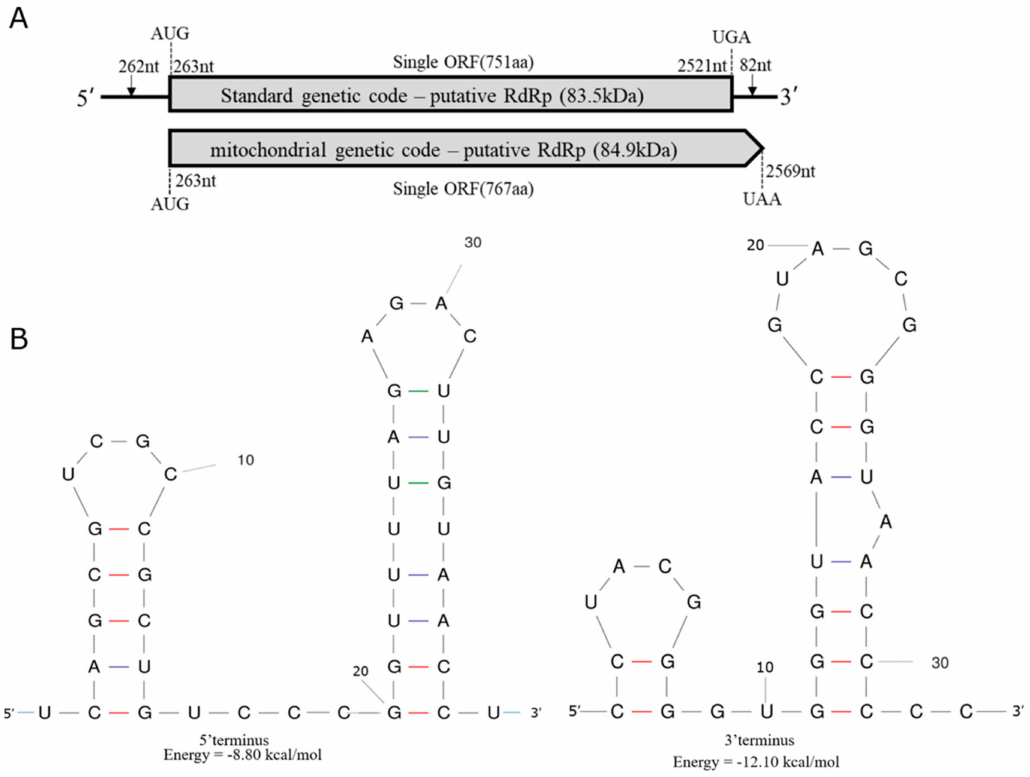
Figure 1. The genome organization of Phoma matteucciicola ourmia-like virus 1 (PmOLV1). ( A ) Schematic representation of PmOLV1 RNA genome. The open reading frame (ORF) and the untranslated regions (UTRs) are indicated by an open bar and single lines, respectively. ( B ) Predicted secondary structures of 5 (cid:48) ( left ) and 3 (cid:48) ( right ) termini of PmOLV1. A homology search with BLASTP showed that this 83.5 kDa protein was most closely related to the RNA dependent RNA polymerases (RdRps) of Epicoccum nigrum ourmia-like virus 2, Penicillium sumatrense ourmia-like virus 1, and Pyricularia oryzae ourmia-like virus 1 (Table 1). Furthermore, a conserved domain database (CDD) search and multiple protein alignment confirmed that this protein had eight conserved motifs that are characteristic of the RdRps of ( + ) ssRNA mycoviruses (Figure 2) [12]. However, if the mitochondrial genetic code is applied, the predicted RdRp could be 16 aa longer and result in an 84.90 kDa protein between the initiation AUG triplet and the termination UAA triplet (Figure